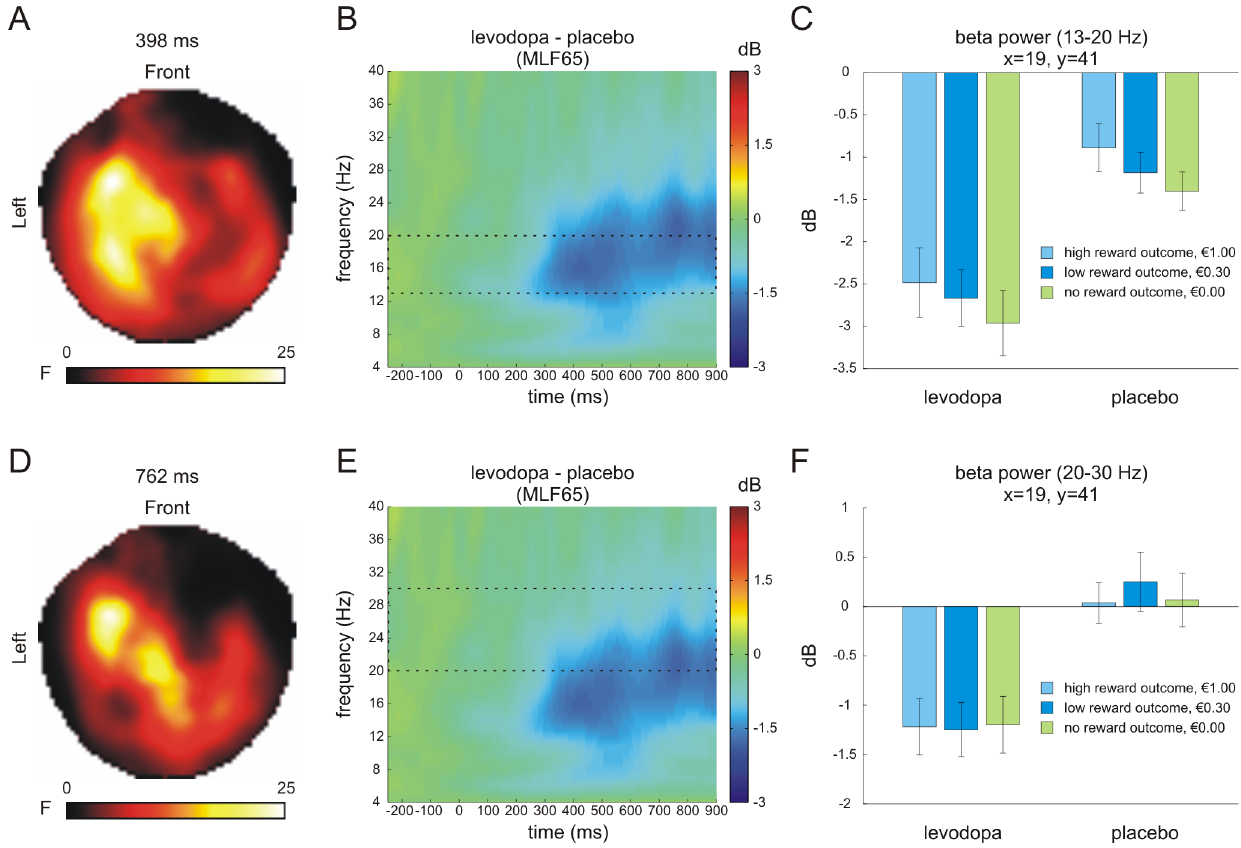
Figure 5. Time-frequency effects for reward outcome. SPM-based analyses across all sensors and time-points revealed main effects of drug group (levodopa, placebo) at left frontal sensors for both the low beta band (peak at 398 ms; nearest sensor: MLF65) (A) and high beta band (peak at 762 ms; same nearest sensor) following outcome presentation (D). Both effects were driven by reduced beta power in the levodopa group compared to the placebo group (C and F). In addition, power in the low beta band decreased as a function of outcome magnitude (i.e., from high to low magnitude) at the peak voxel showing the group effect (C). Left columns show statistical parametric maps of the F-statistics, middle columns show the time-frequency plots as extracted from the nearest channel, and right columns show the effects for each condition at the peak time point as extracted from voxel space. Dashed boxes in B and E indicate the low (13–20 Hz) and high (20–30 Hz) beta band, respectively. Error bars in C and F denote one SEM.